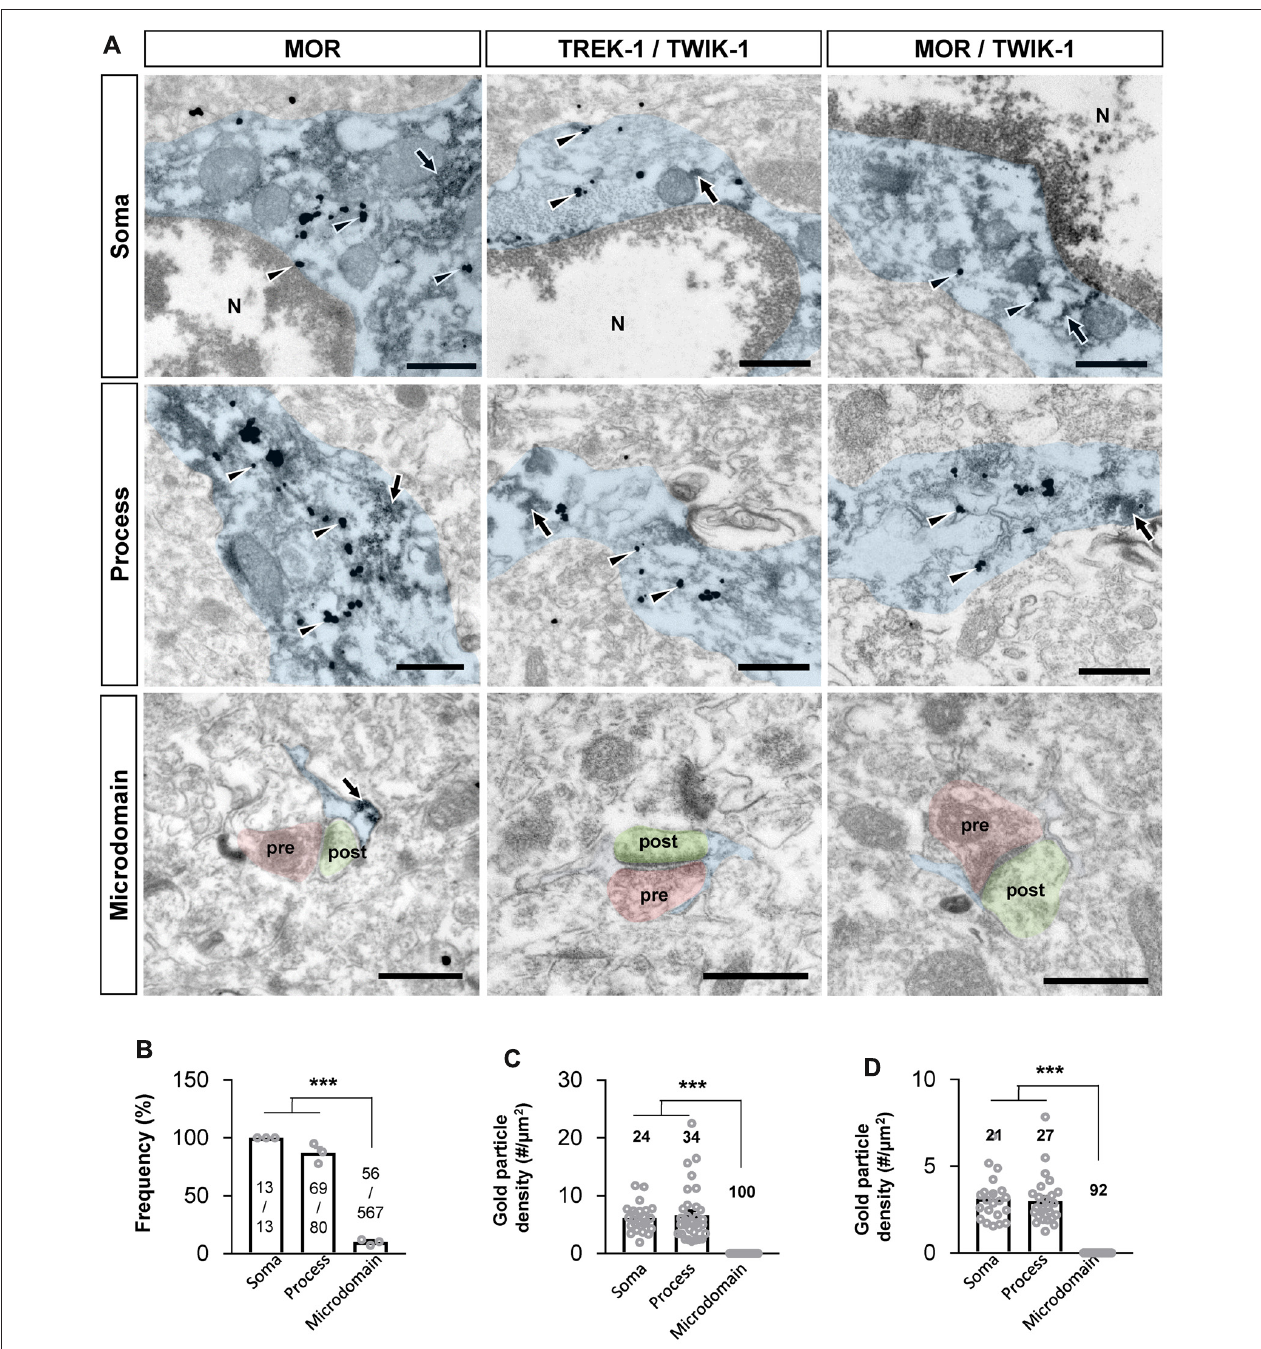
FIGURE 5 | MOR and TREK-1 co-localizes in astrocytic soma and process. (A) Subcellular distribution (soma, process and microdomain) of MOR in astrocyte (left). MOR is stained with immunogold with silver enhancement (dark specks, arrowheads), and GFP, representing astrocyte, is stained with immunoperoxidase (dark amorphous deposits, arrows). Cellular distribution of double labeling of TREK-1/TWIK-1 (middle) and MOR/TWIK-1 (right) in astrocyte. TREK-1 or MOR is stained with immunogold with silver enhancement (dark specks, arrowheads), and TWIK-1 is stained with immunoperoxidase (dark amorphous deposits, arrows). The soma, process, and microdomain of the astrocyte was colored blue. Presynaptic axon terminal (pre) and postsynaptic dendrite (post) were colored red and green, respectively. N is nucleus. Scale bar indicates 500 nm. (B) Summary bar graph for the frequency of MOR detection in each subcellular structure of astrocytes. Numbers in the bar graph are the number of MOR-positive soma, processes or microdomains out of total number of profiles observed. The data was collected from three animals. One-way analysis of variance (ANOVA) with Tukey’s multiple comparison test ( ∗∗∗ P < 0.001). (C,D) Summary bar graph for the gold particle density of TREK-1 (C) or MOR (D) in each subcellular structure of TWIK-1-positive astrocytes. Numbers in the bar graph indicate the number of images analyzed from three different animals. One-way ANOVA with Tukey’s multiple comparison test ( ∗∗∗ P < 0.001).